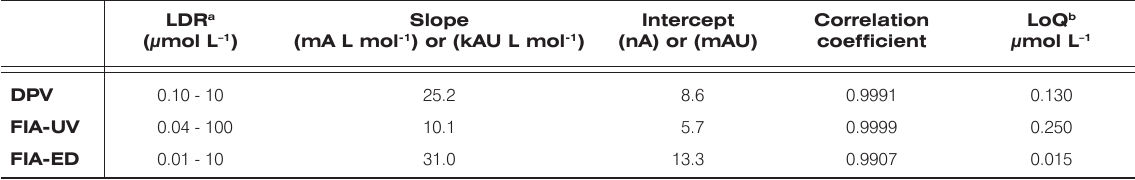
Figure 4. FIA-ED amperometric responses of metoclopramide with the concentration of 10; 8; 6; 4; 2; 1 µmol L -1 at BDDFE; concentration in µmol L -1 marked above the peaks. Carrier solution B-R buffer pH 6, flow rate 5.0 mL min −1 , E metoclopramide solution. Table 1. Selected parameters of the concentration dependences of metoclopramide, obtained by DPV and FIA with spectrophotometric and amperometric